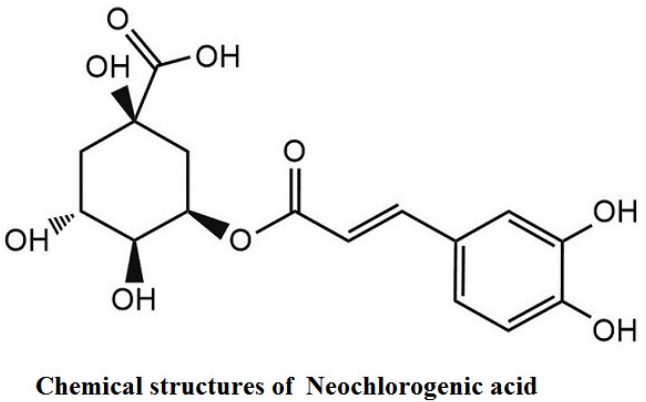
Figure 7. The chemical structure of nCGA.